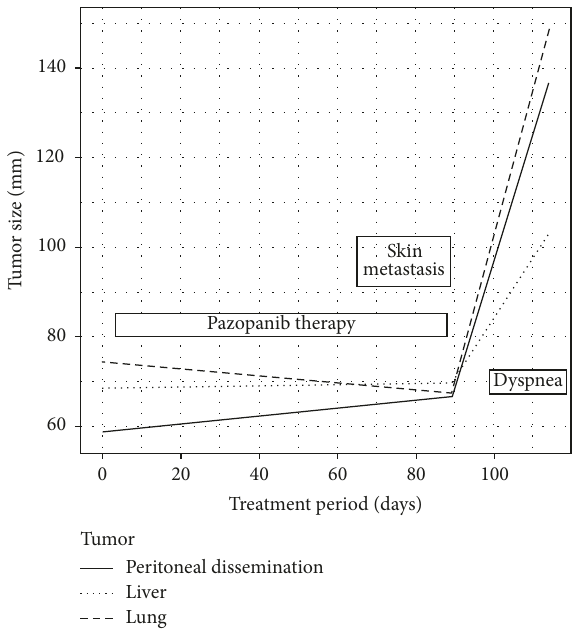
Figure 1: The graph shows the change of tumor size with course of treatment. The sum of the patient’s tumor diameters increased after cessation of pazopanib